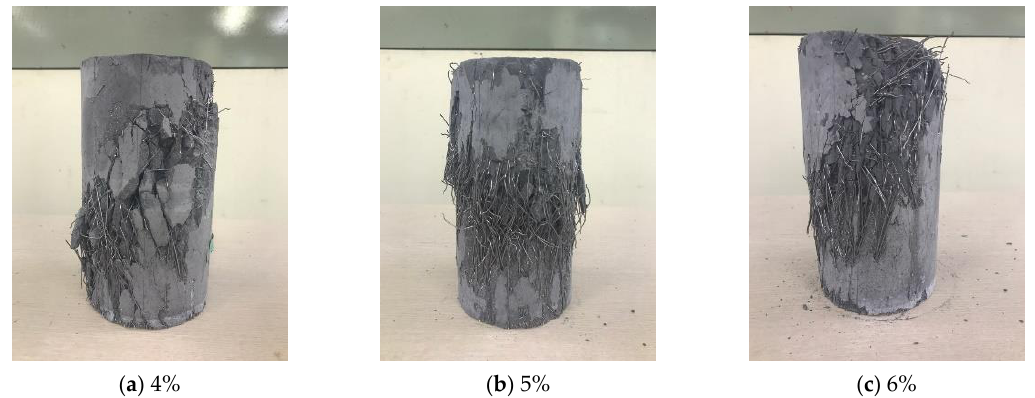
Figure 12. Compressive fracture pattern with respect to fiber volume fraction.